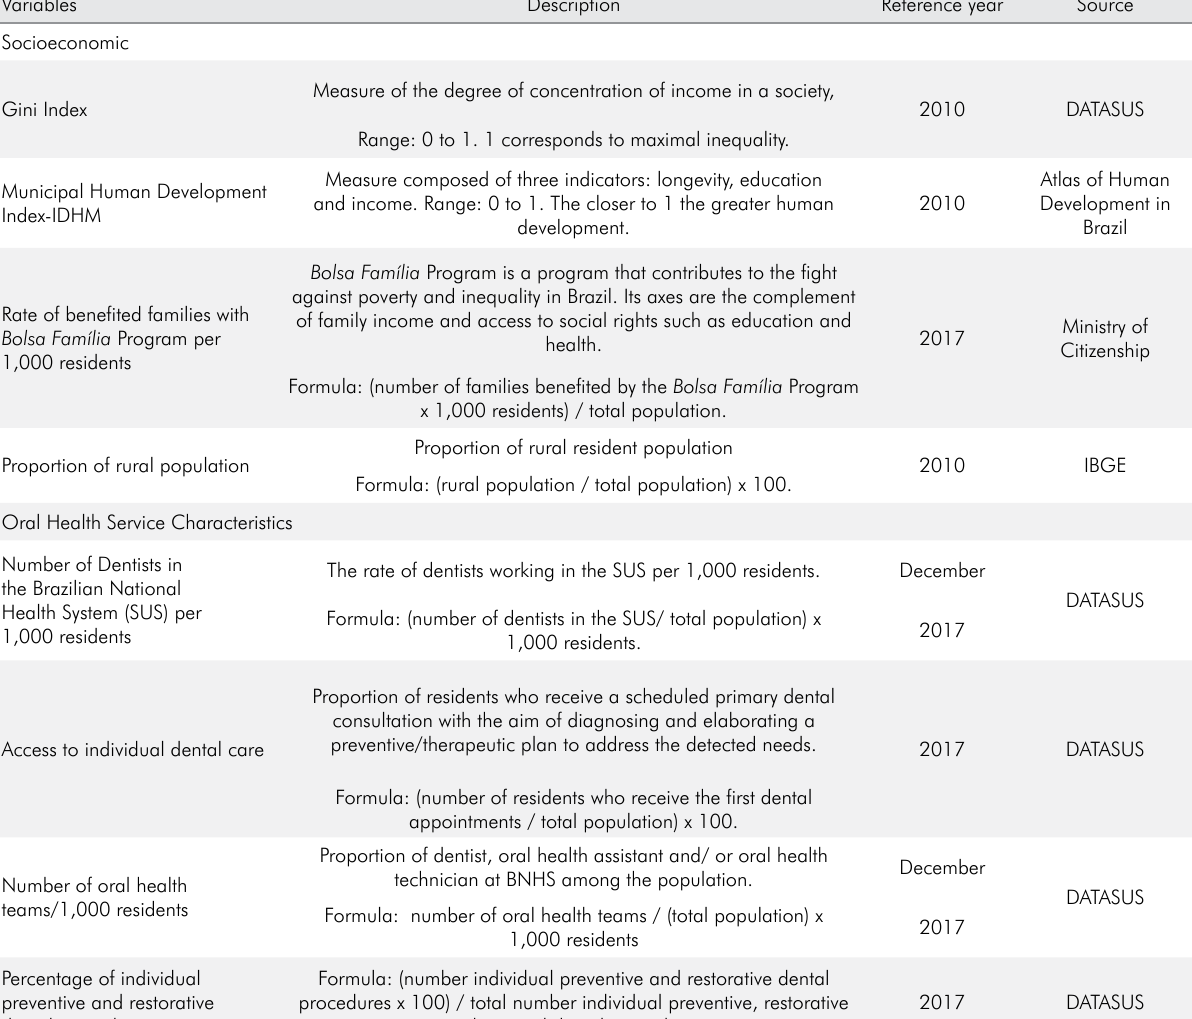
Table 1. Description of the independent variables at municipal